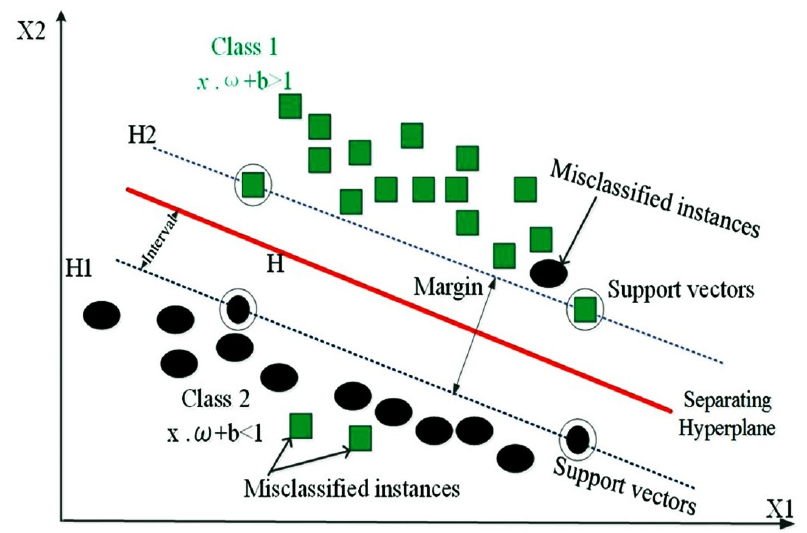
Figure 3. Illustration of the Support Vector Machines (SVM) method.